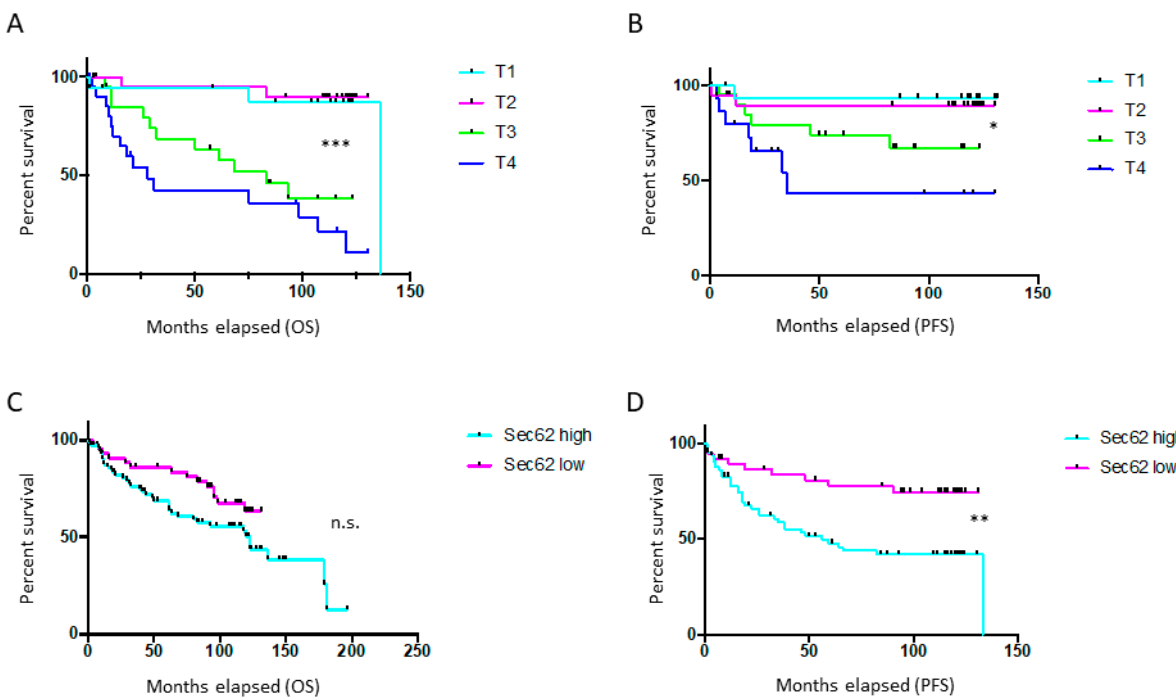
Figure 1. Survival of melanoma patients depending on T stages (malignant melanoma (MM) only) and SEC62 expression level (MM + melanoma metastases (MET)): ( A ) overall survival (OS) T1 vs. T2 vs. T3 vs. T4l ( B ) progression-free survival (PFS) T1 vs. T2 vs. T3 vs. T4; ( C ) OS Sec62-high ( n = 75) vs. Sec62-low ( n = 46); ( D ) PFS Sec62-high vs. Sec62-low; log-rank test. Median OS was 80.41 months and median PFS was 57 months for all MM patients; n.s.—non significant; *— p < 0.05; **— p < 0.005; ***— p < 0.001.